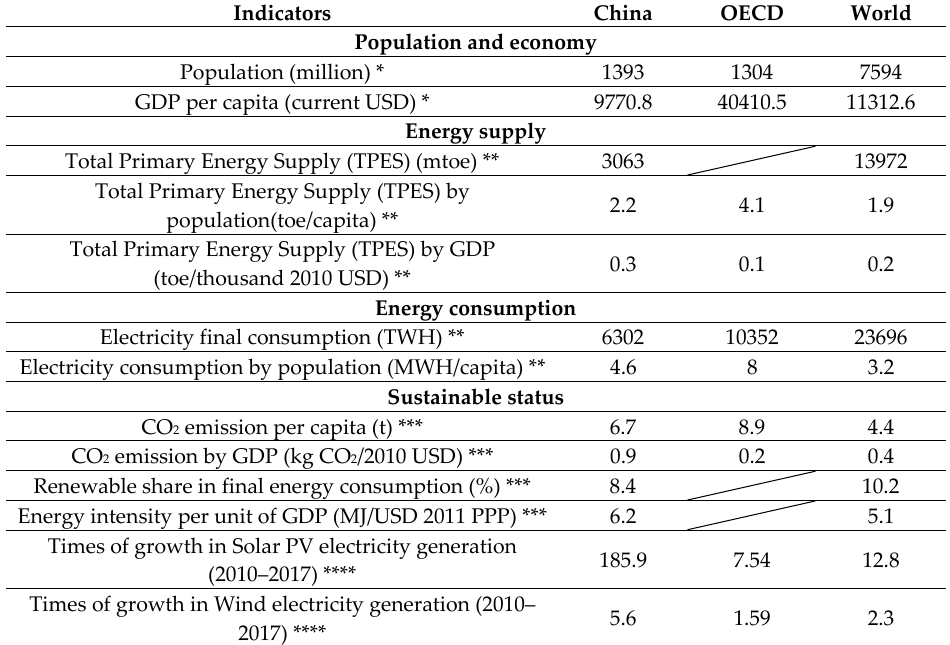
Table 2. Some critical data of population, economy, energy supply, consumption, and sustainable conditions in China (for 2016–2018).